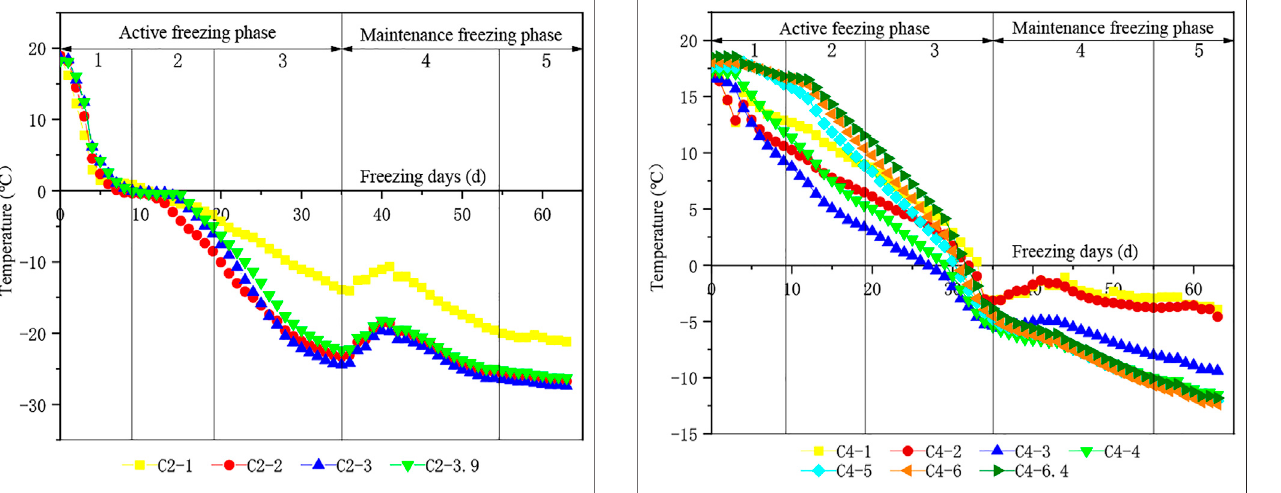
FIGURE9| CorrelationbetweenthetemperatureintemperatureholeC2 and time.